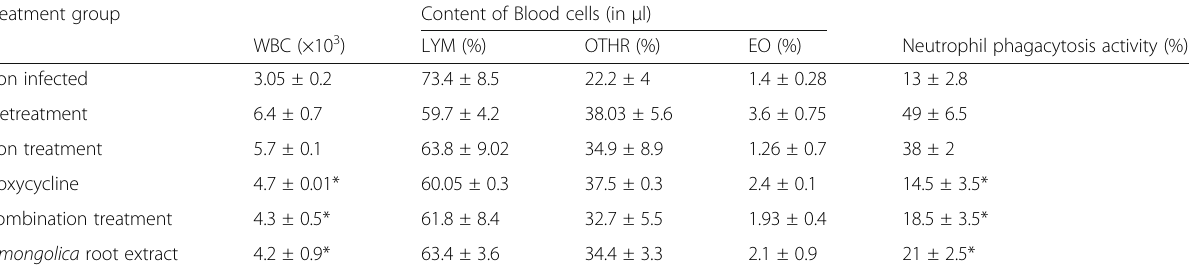
Table 2 Haematological parameters of B. melitensis -infected BALB/c mice treated with C. mongolica root extract, antibiotic or the combination of both